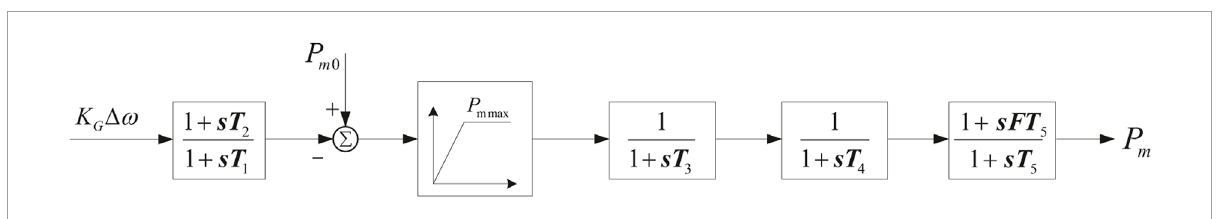
FIGURE 4 The block diagram of the WSCC Type G governor.